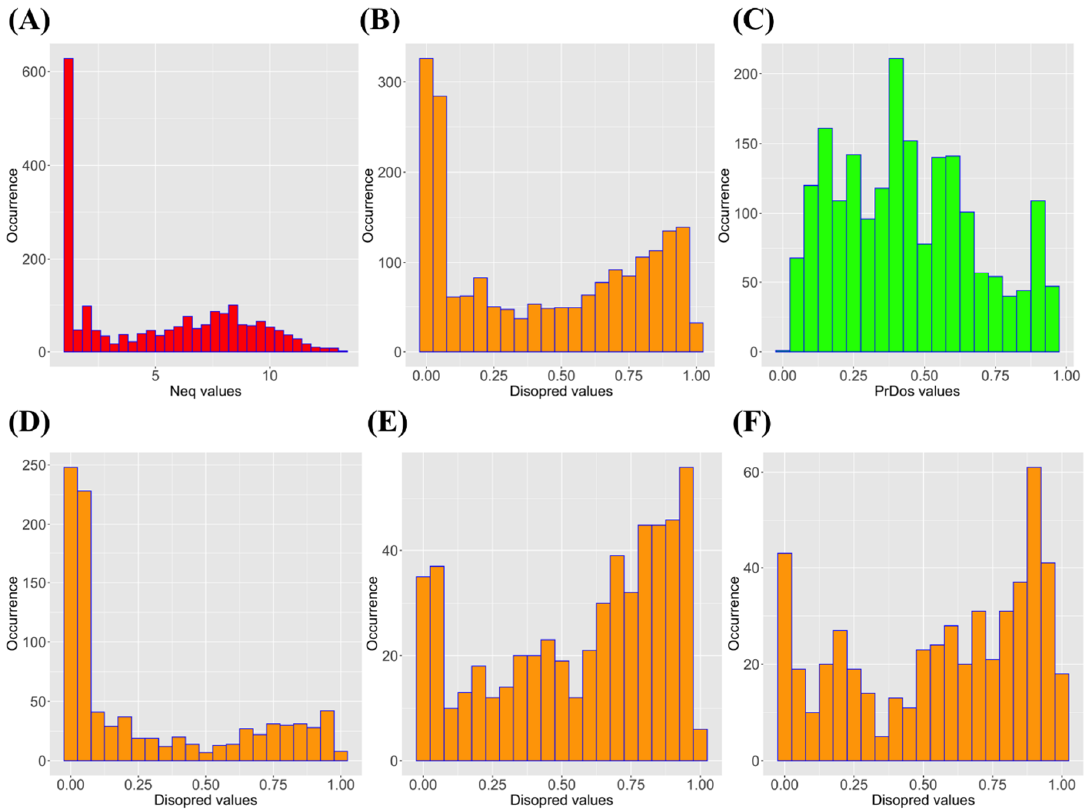
Figure 1. Distribution of an equivalent number of PBs ( N eq) and prediction disorder values. ( A ) N eq values (in red), ( B ) Disopred3 values (in orange), ( C ) PrDOS values (in green), ( D ) Disopred3 values for N eq values lower than 4, ( E ) Disopred3 values for N eq values between 4 and 8, and ( F ) Disopred3 values for N eq values higher than 8.